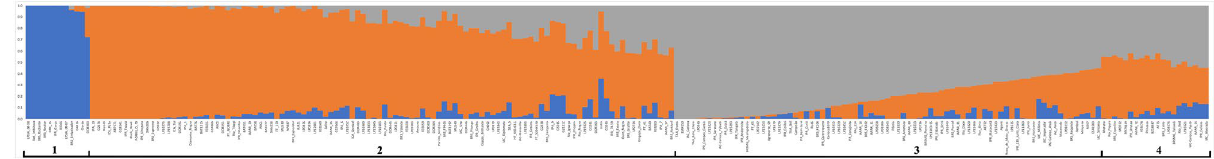
Figure 3. Analysis of the population structure using 219 accessions belonging to the Brazilian common bean diversity panel with K = 3: (1) corresponds to the group of common beans of Andean origin; (2) mostly formed by Mesoamerican accessions of black, cream, red, and other seed tegument colors; (3) mostly formed by Mesoamerican accessions from the carioca commercial group; and (4) mostly formed by Mesoamerican accessions with membership coefficient < 0.6 for the previous groups. Figure produced in R v.4.0.